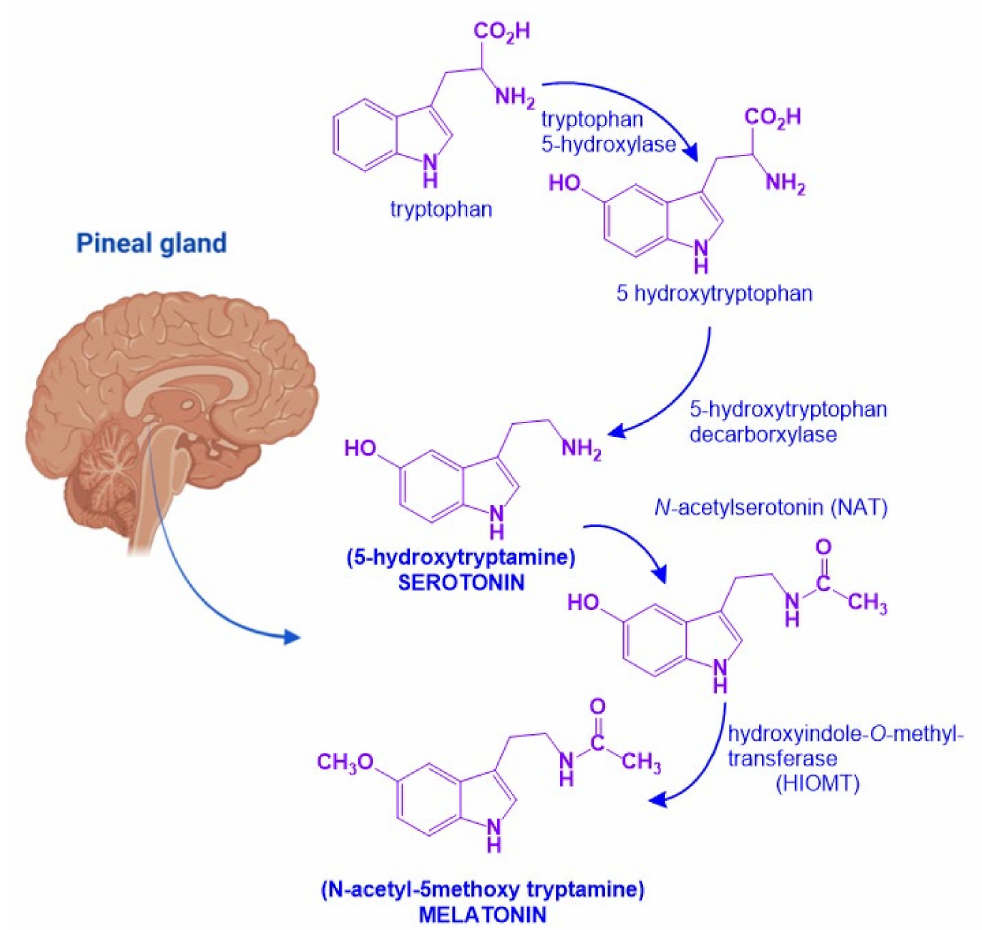
Figure 2. Melatonin biosynthetic pathway. Melatonin biosynthesis in the pineal gland starts from tryptophan and involves four sequential enzymatic steps to render 5-hydroxytryptophan, N -acetylserotonin, 5-hydroxytryptamine (serotonin), and N -acetyltryptamine (melatonin). Figure created with Biorender.com